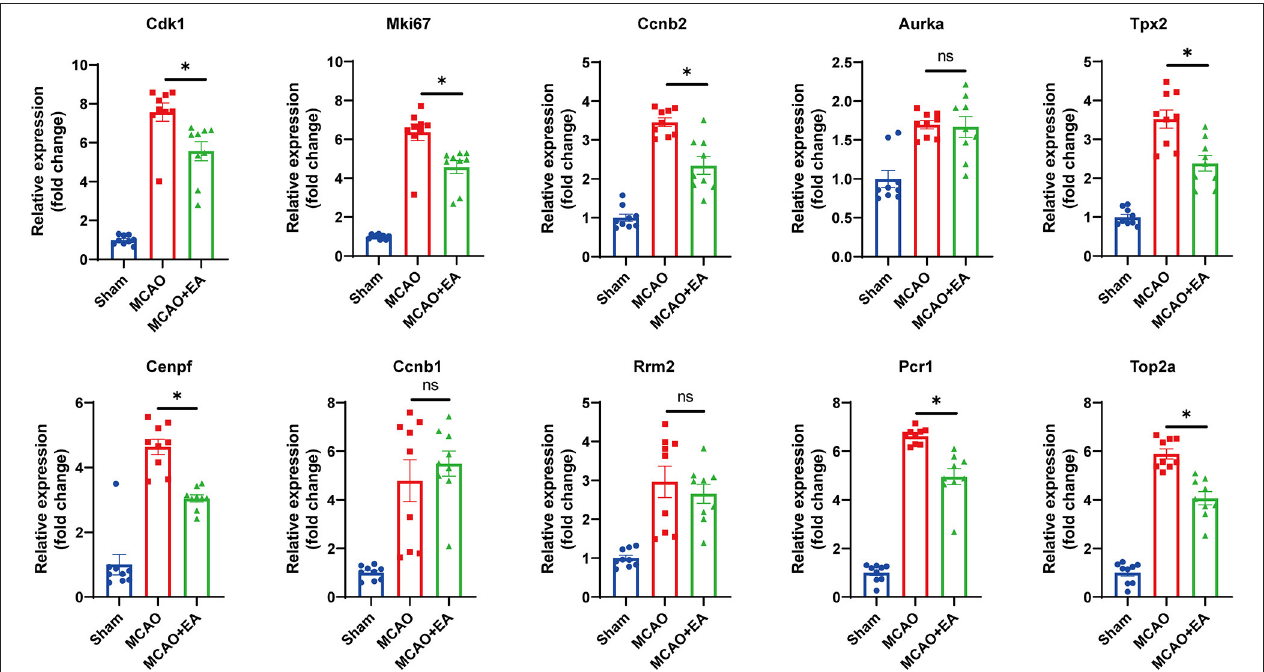
FIGURE 6 | Validation of 10 hub genes with RT-qPCR. Statistical graph shows fold change of mRNA expression of DEGs regulated by EA treatment, normalized to β -actin level. Data are represented as means ± SEM, n = 3 mice/group (with three technical replicates); One-way ANOVA followed by Bonferroni (if equal variances assumed) or Dunnett’s T3 (if equal variances not assumed) post-hoc test was used for statistical analysis, * p < 0.05, ns p >